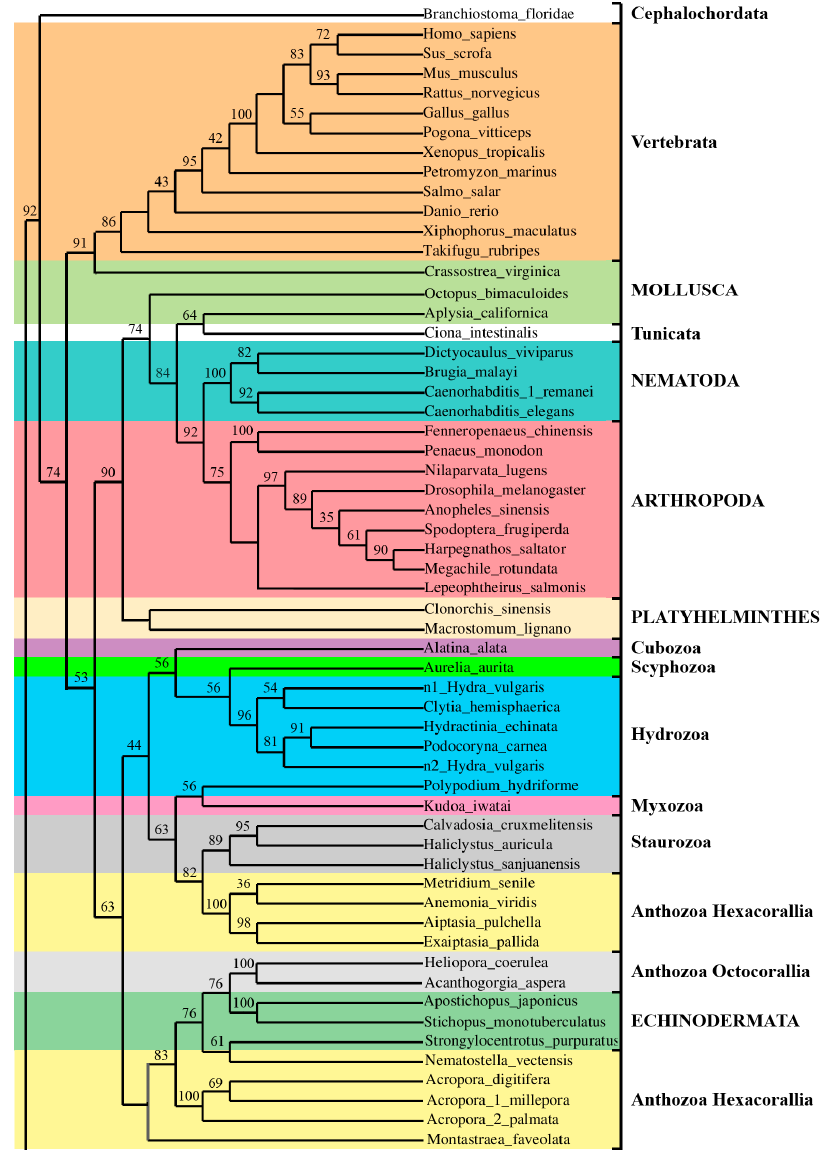
Figure 6. Maximum Likelihood (ML) bootstrap consensus tree based on AvTCTP and homologues from other Eumetazoa. The tree was generated using MEGA 7.0 [39] including TCTP from different species. All the sequences used were obtained from GenBank at NCBI. The bootstrap consensus tree inferred from 1000 replicates is taken to represent the evolutionary history of the taxa analysed. Bootstrap values less than 30% are not shown. The percentage of replicate trees in which the associated taxa clustered together in the bootstrap test (1000 replicates) are shown next to the